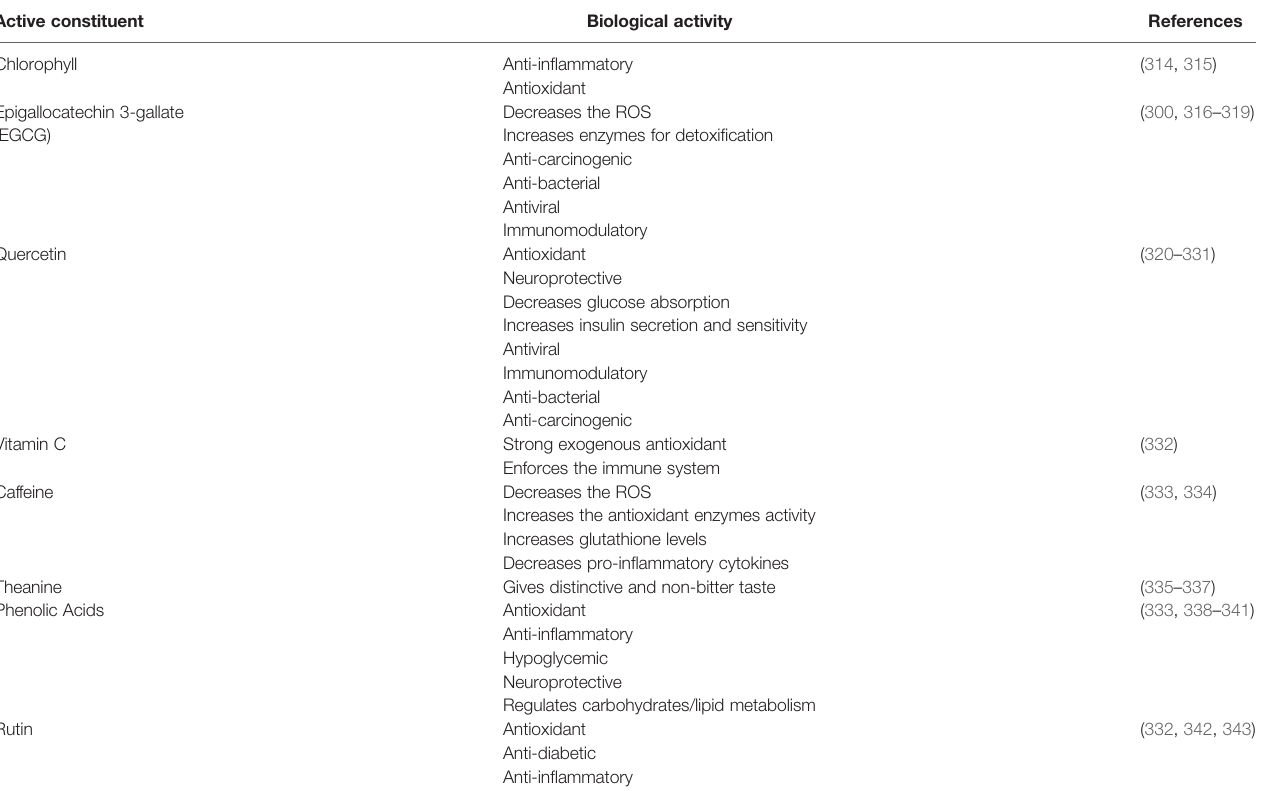
TABLE 4 | Biological activities of matcha active